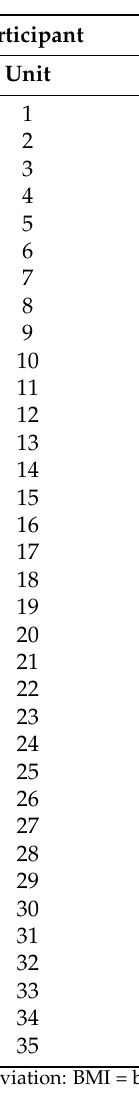
Table A2. Alcohol outcomes—individual participant